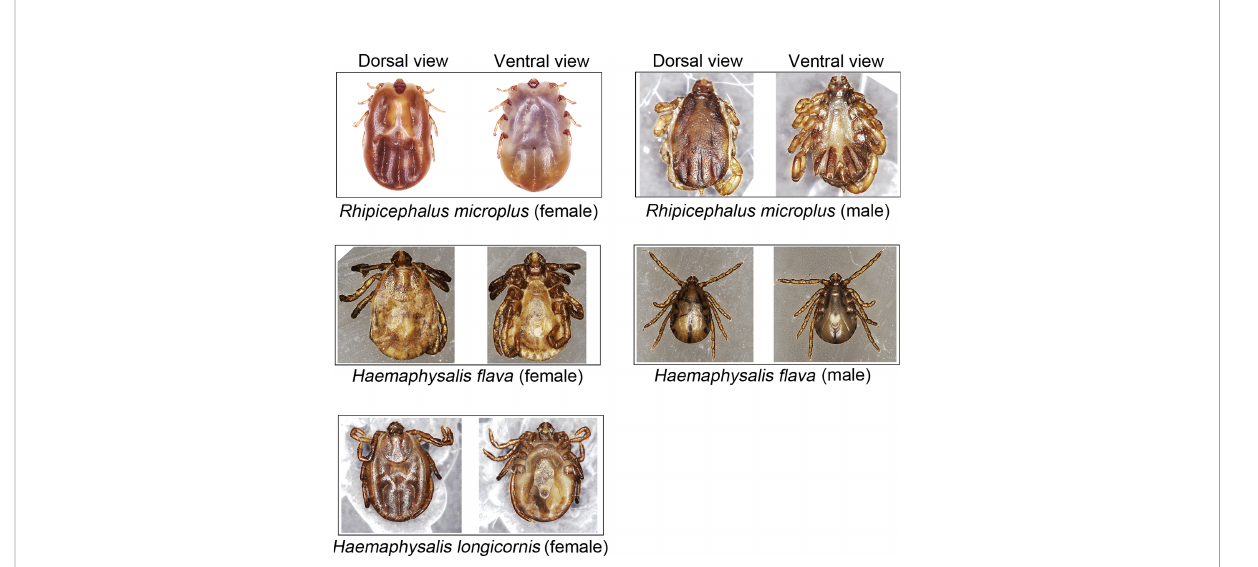
FIGURE 2 Haemaphysalis spp. and Rhipicephalus microplus ticks collected in this